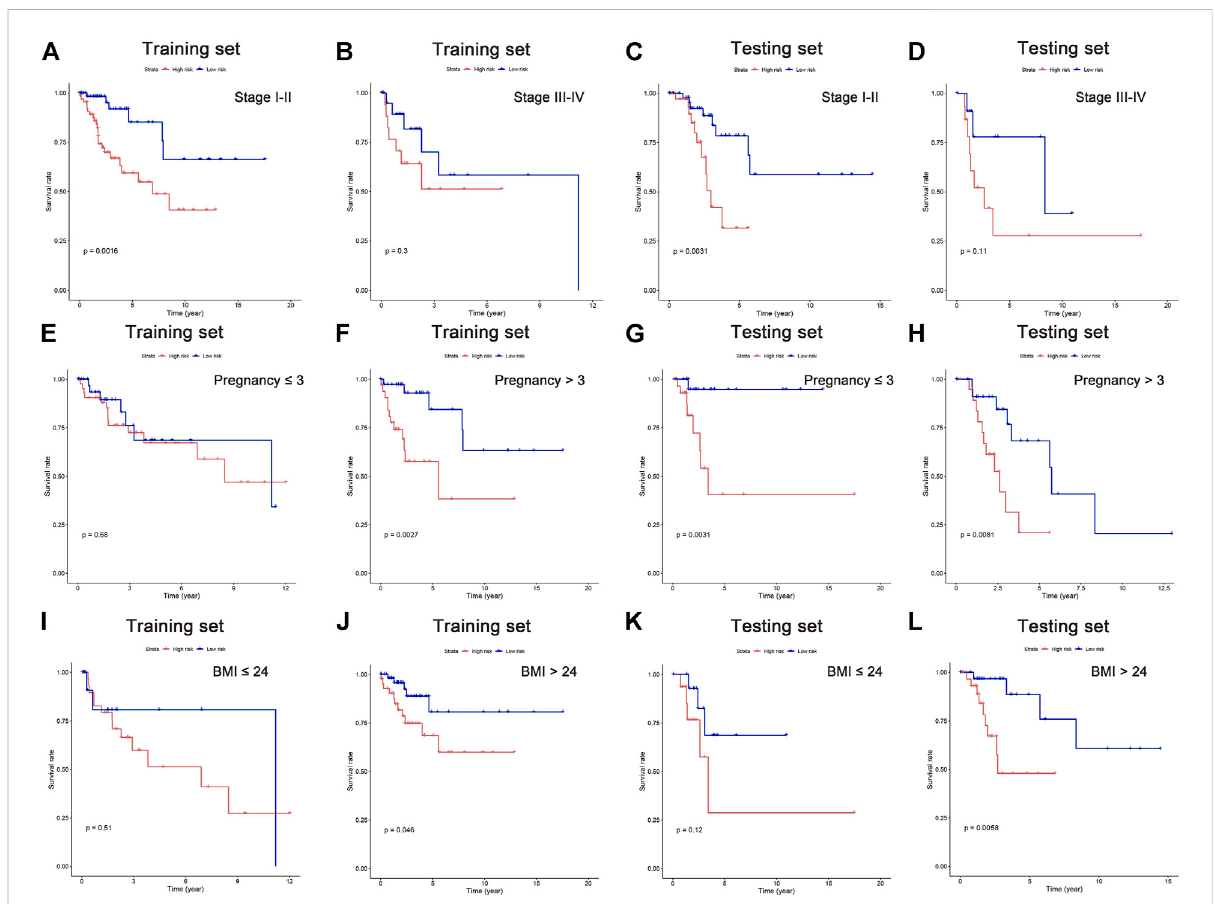
FIGURE 6 Survival analysis in subgroups of independent clinicopathological factors. Kaplan – Meier curves showing the prognostic value in subgroups of tumor stage (A – D) , pregnancy (E – H) , and BMI (I – L)